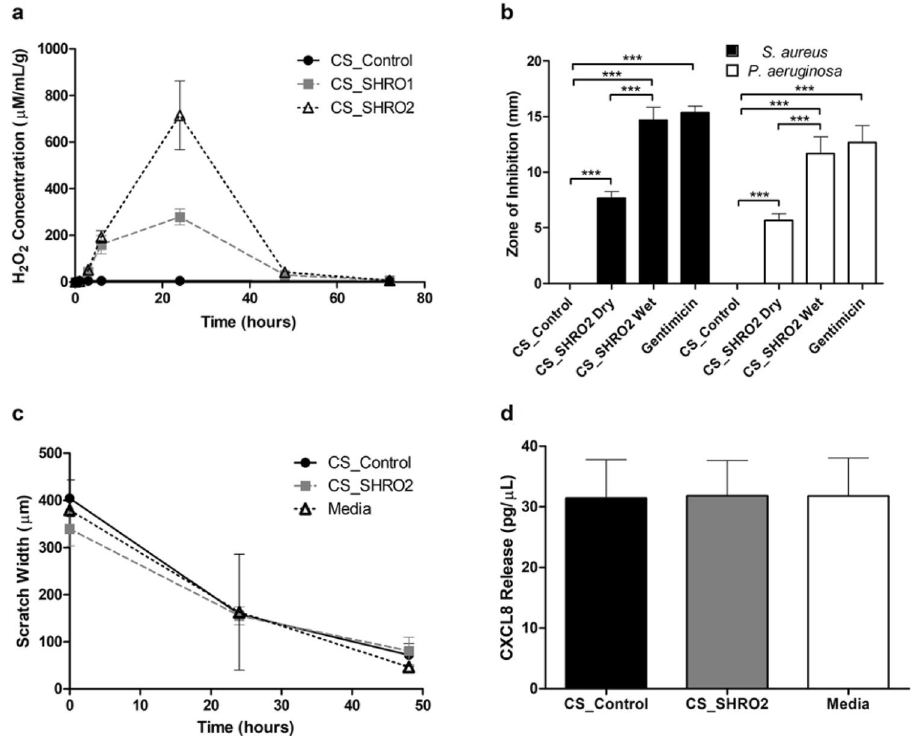
Figure 5. ( a ) Normalised H 2 O 2 release for CS_Control, CS_SHRO1 and CS_SHRO2 cements in distilled water (mean ± SD, n = 3). ( b ) Zones of Inhibition for Staphylococcus aureus ( S. aureus ) and Pseudomonas aeruginosa ( P. aeruginosa ) in the presence of CS_Control, CS_SHRO1 and CS_SHRO2 cement supernatants (mean ± SD, n = 3). ( c ) Scratch assay and (d) human IL-8/CXCL8 enzyme-linked immunosorbent assay to determine the cellular effect of CS_Control and CS_SHRO2 scaffolds in comparison to media alone on wound healing using osteoblast cells (n = 2) (GraphPad Prism